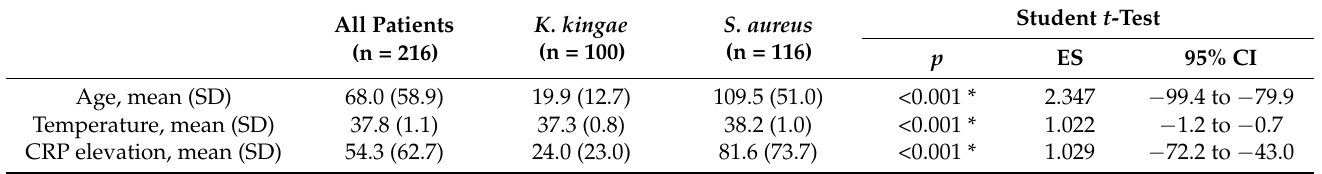
Table 1. Differences in clinical and laboratory variables between S. aureus and K. kingae germ groups. All